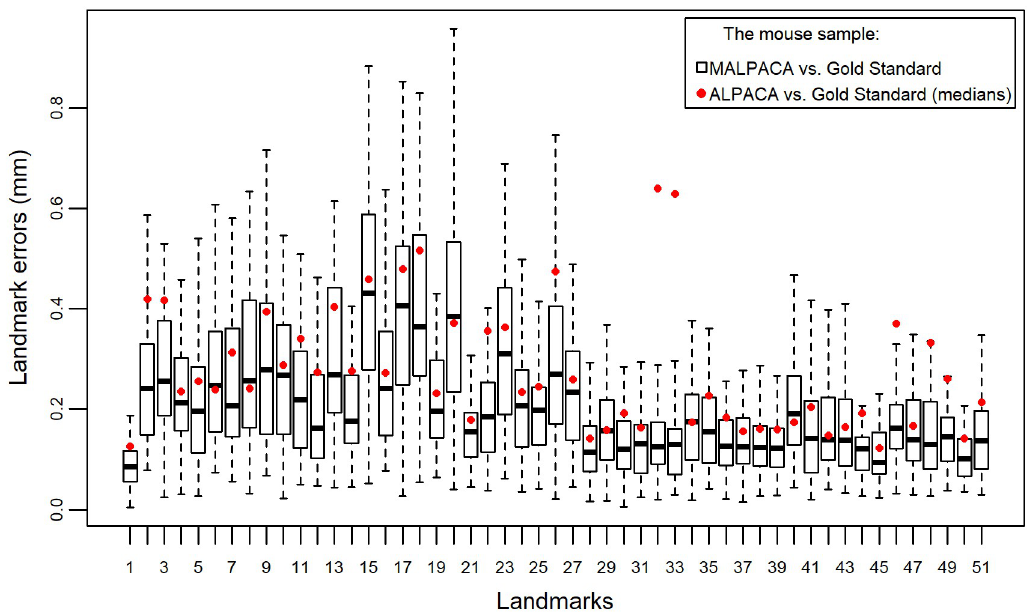
Fig 2. Comparison of individual landmark errors for the mouse sample. Errors represented by Euclidean distances (for errors expressed in percentage of centroid sizes, see S3 Fig). Each column represents errors between MALPACA-derived estimates of all 54 mouse specimens for one landmark and their corresponding Gold Standard (GS) landmarks. Red dots: each represents the median of errors between the estimates of the synthetic template ALPACA of all 54 mouse specimens for one landmark and their corresponding GS